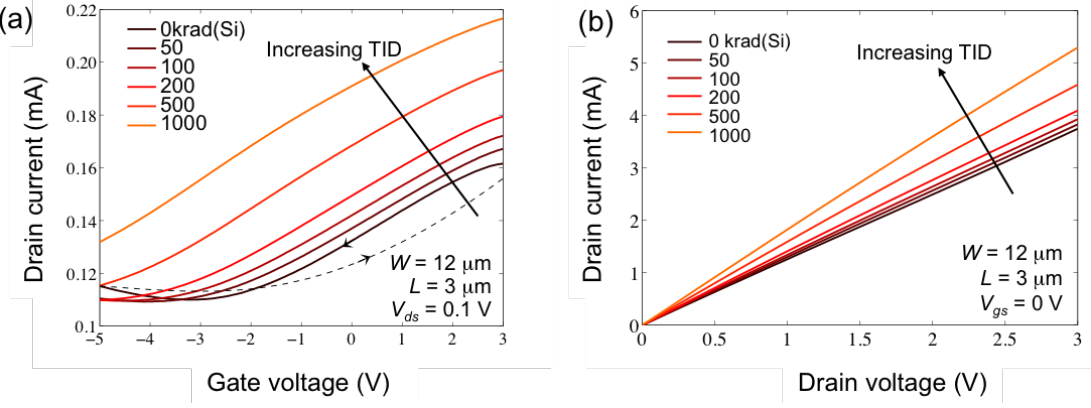
Figure 6. Extraction of hysteresis width ( h ) as a function of TID for devices tested in air and with flowing N purge. Symbols are data and dashed line is the mean hysteresis 2